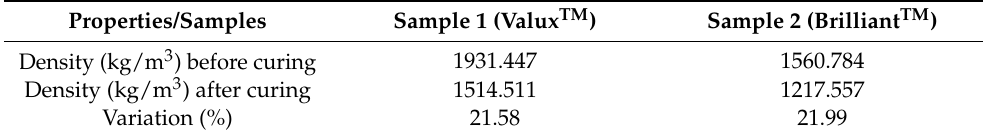
Table 2. Pycnometric results for the two investigated